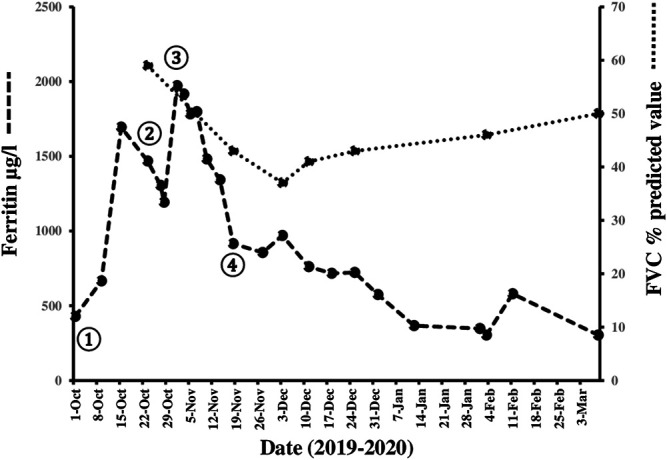
Timeline of pharmacologic interventions, changes in serum ferritin levels and FVC from October 2019 until March 2020. While the patient was treated with high-dose prednisone, azathioprine and tacrolimus ①, the respiratory function suddenly deteriorated and serum ferritin levels (y-axis left) rose from 428 to 1,695 μg/L (reference range 13–150 μg/L, dashed line). Pulse therapy with methylprednisolone and IVIG ② were followed by an ephemeral decrease in serum ferritin levels, which rebounded to the maximum measured value of 1973 μg/L. With the administration of tofacitinib first ③ and nintedanib three weeks later ④ we witnessed an immediate clinical improvement and a prompt, continuous decrease in serum ferritin levels to 304 μg/L, which allowed to taper prednisone in short, 10-days intervals. An initial decline of FVC from 59% to 37% was followed by a modest recovery to 50% of predicted value (y-axis right; dotted line). Details of doses of the medications used, including the tapering scheme of the corticosteroid, are found in the main text.